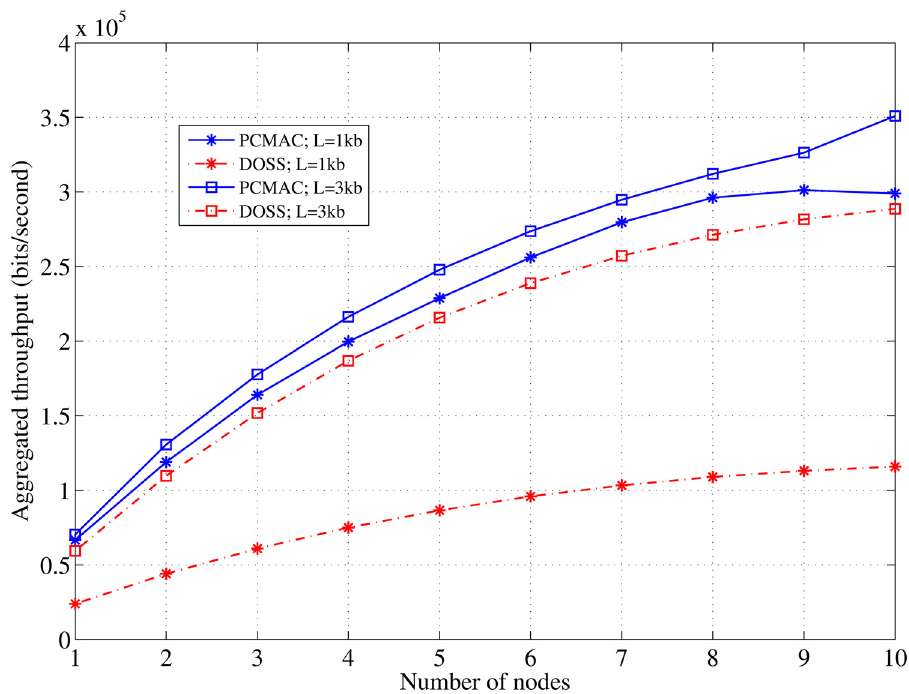
Fig 13. Comparison curves of the aggregated throughput for PCMAC and DOSS MAC in various lengths of the data frame; τ off = 0.5, C =